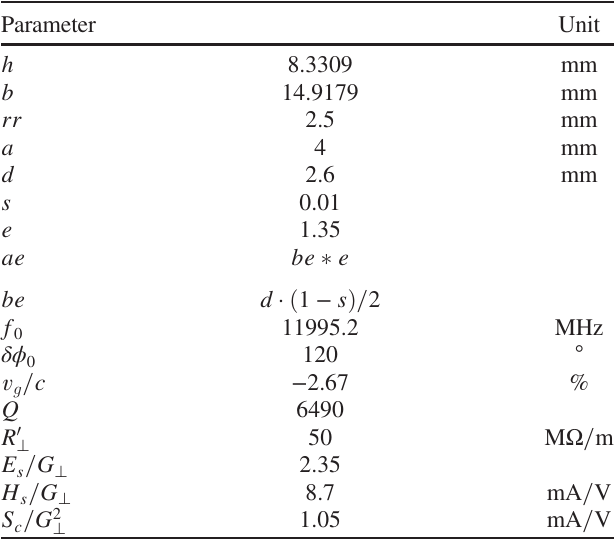
TABLE III. Geometry and rf parameters of a cell.